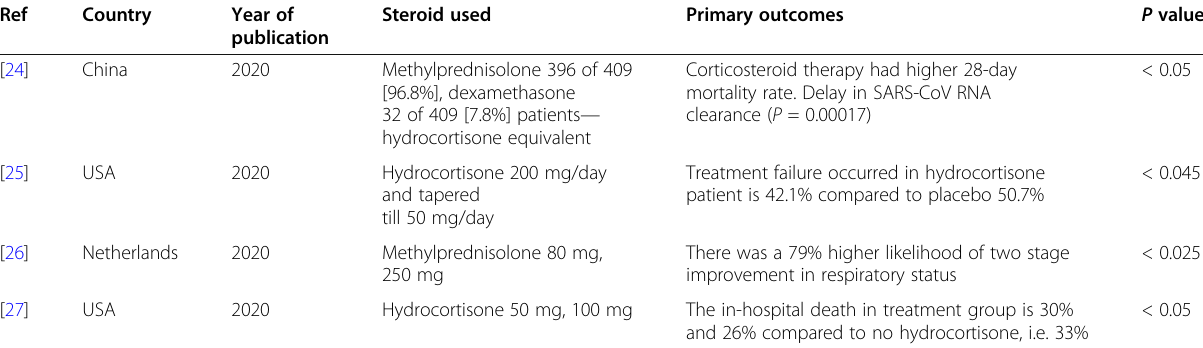
Table 4 Characteristics of published completed trials Ref